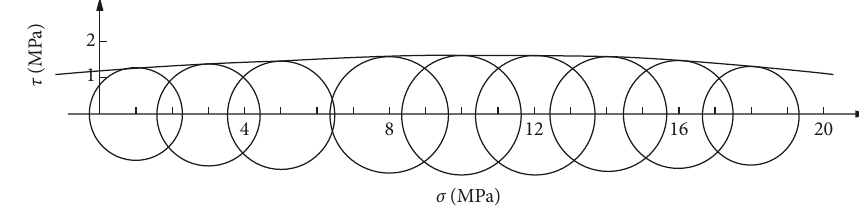
Figure 5: The shear strength envelope of frozen saline silty clay.